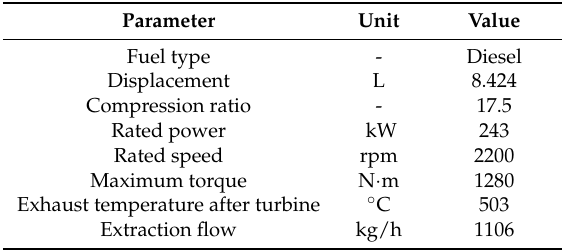
Table 1. Main parameters of rated condition of the diesel